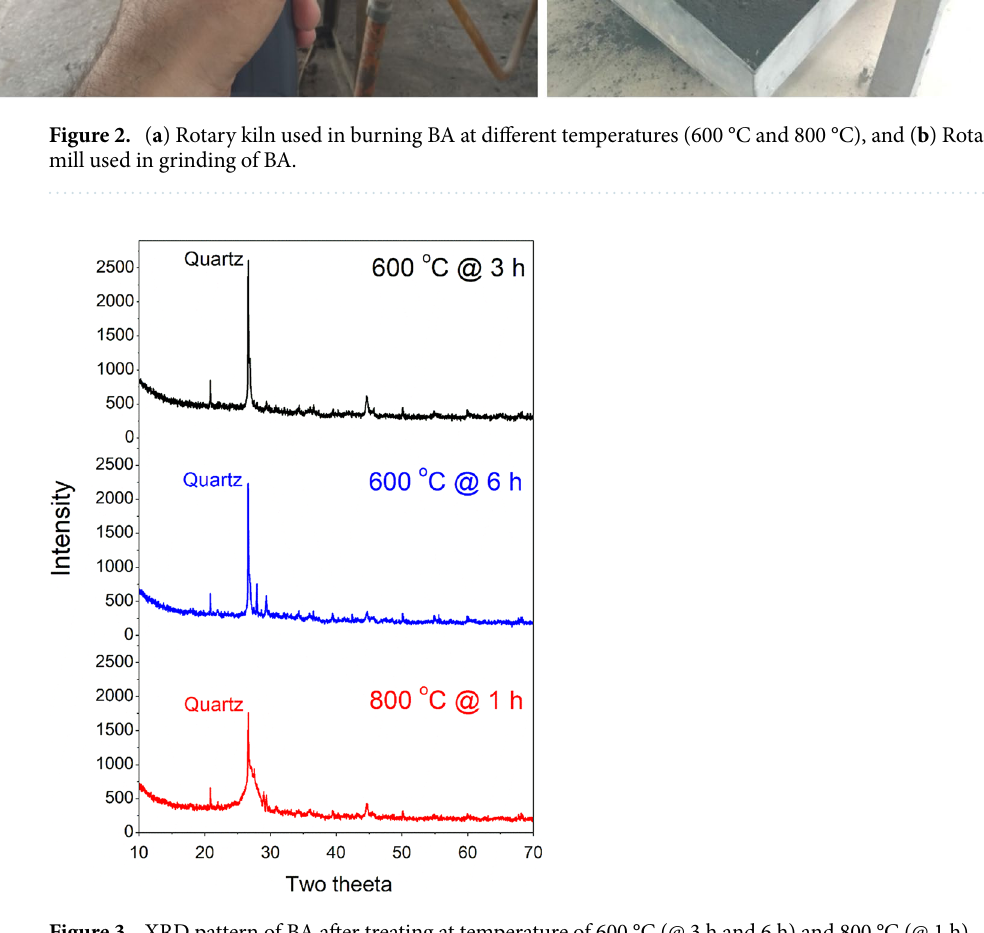
Figure 3. XRD pattern of BA after treating at temperature of 600 °C (@ 3 h and 6 h) and 800 °C (@ 1